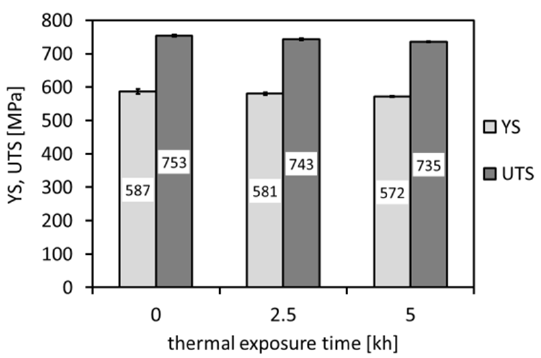
Figure 6. Effect of thermal exposure time at 600 °C on strength properties of investigated P92 steel.